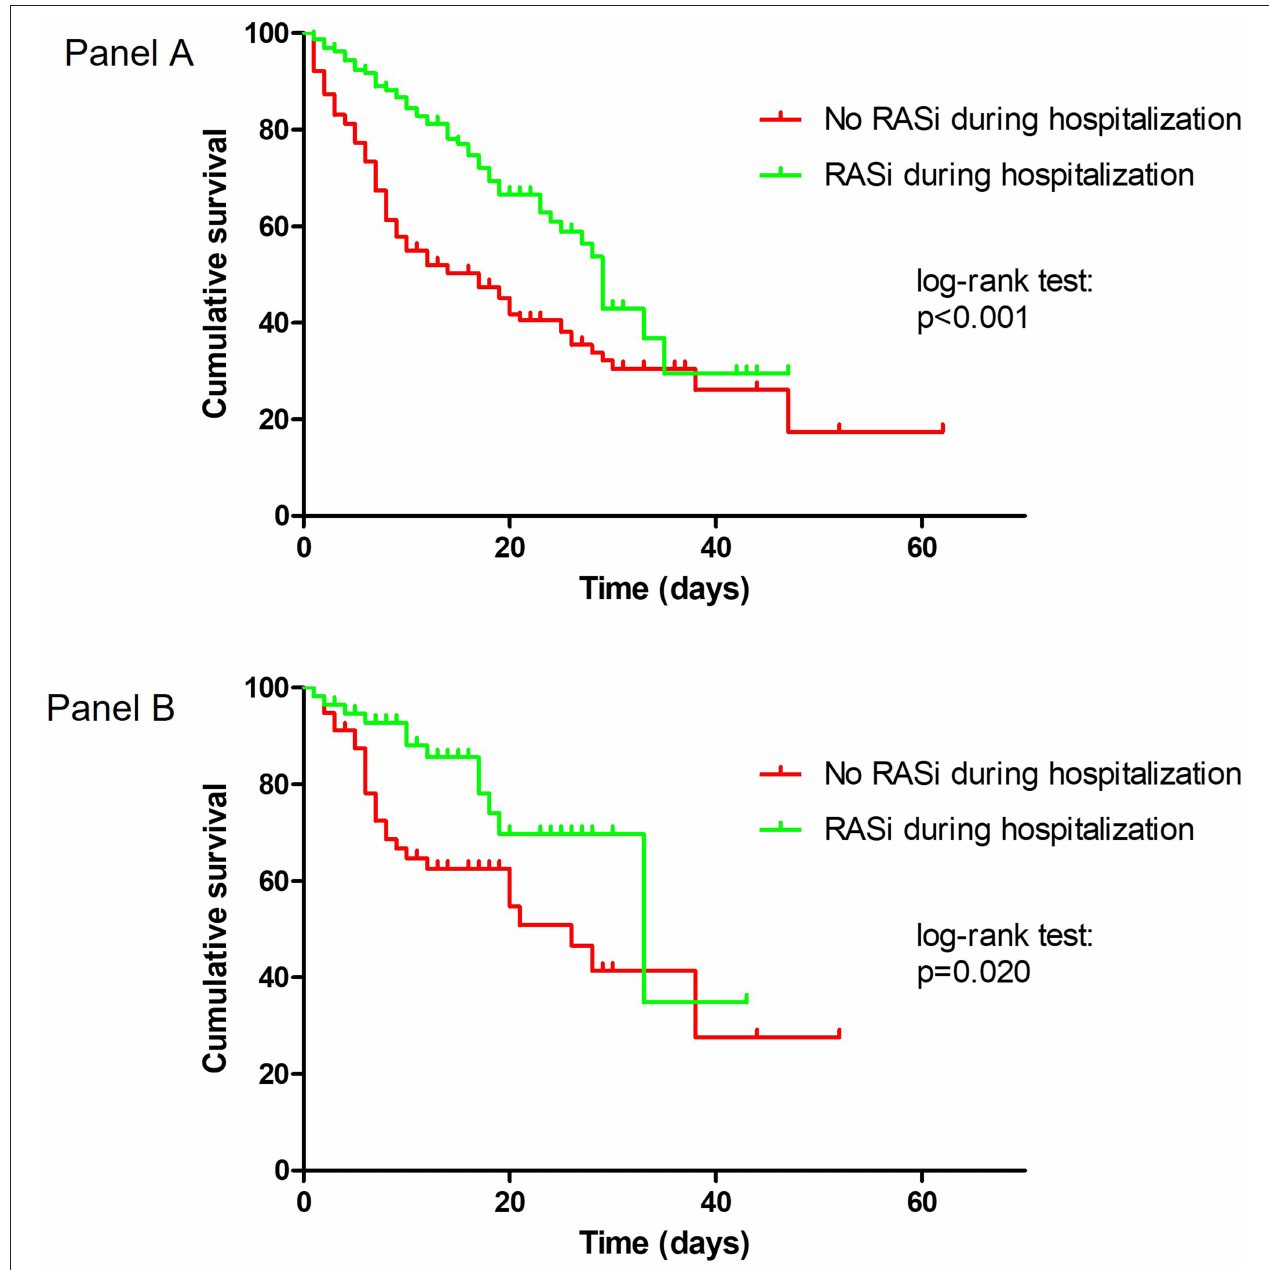
FIGURE 1 | Kaplan–Meier survival curves according to RASi therapy during hospitalization. (A) Overall population. (B) Propensity score matched